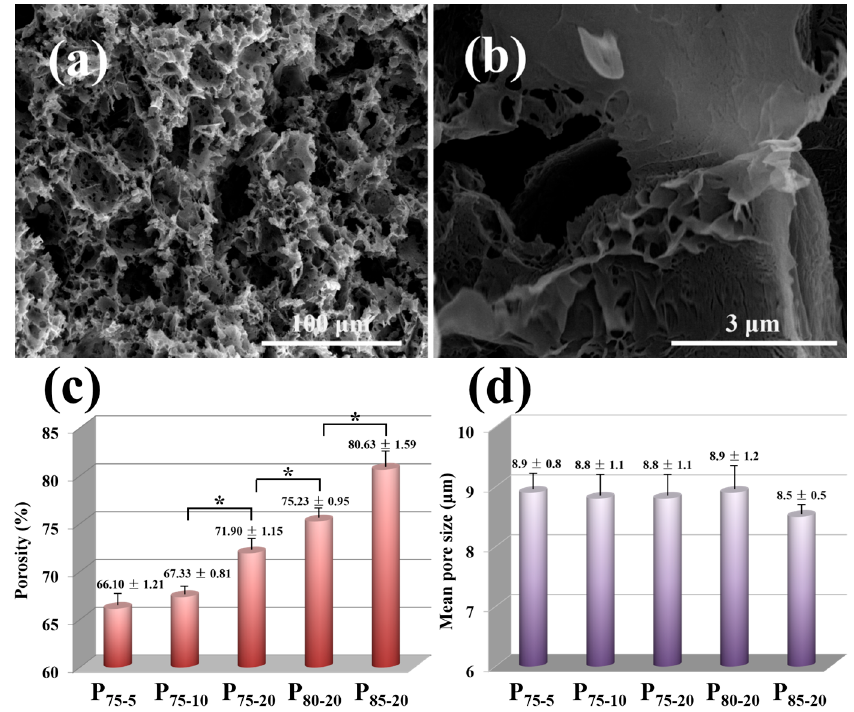
Figure 4. SEM images of ( a ) fracture surface and ( b ) pore wall of P 80-20 . ( c ) Porosity of PLA scaffolds for all sample compositions. ( d ) Mean pore size of scaffolds acquired from SEM images. * indicates p < 0.05.